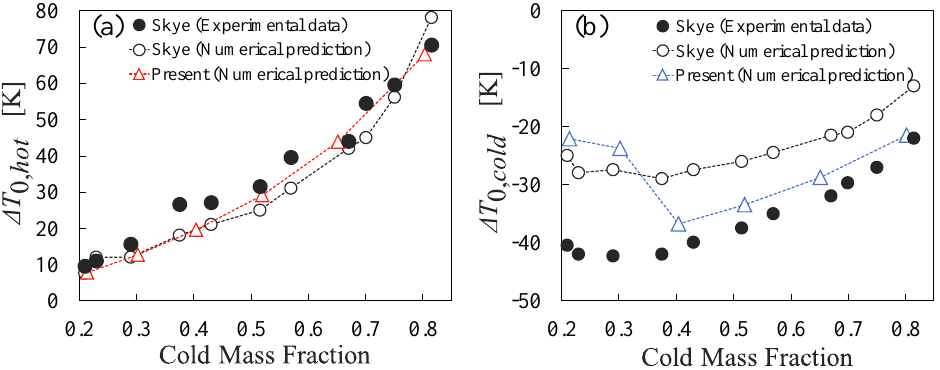
Figure 3. Total temperature separation: ( a ) hot exit, ( b ) cold exit.